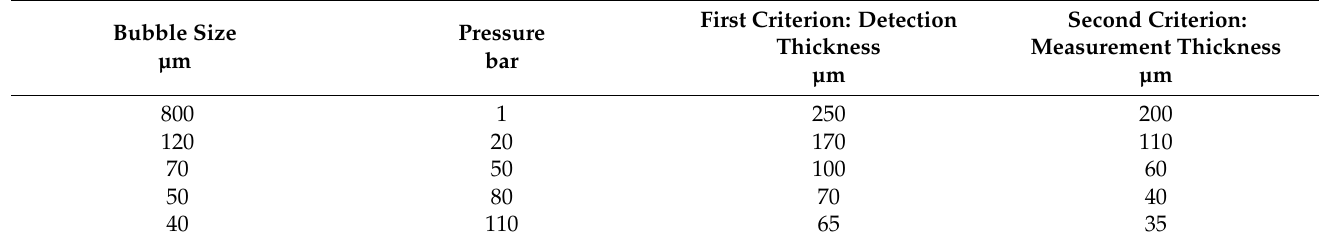
Table 1. Spatial resolution: thickness range associated with the bubble size (pressure dependent).